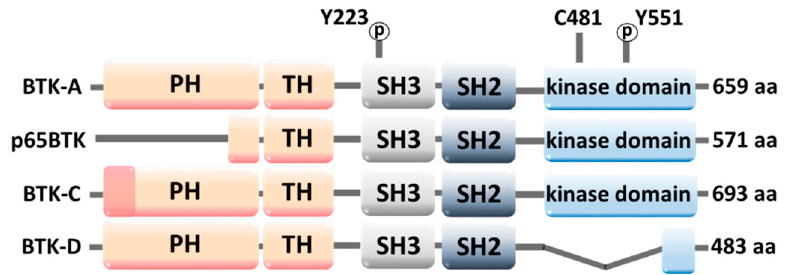
Figure 2. Structures of BTK isoforms. pY223 and pY551 are activating phosphorylation sites; C481 is a binding site for BTK inhibitors ibrutinib, spebrutinib, and acalabrutinib [10]. In this review, the term “BTK” refers to the BTK-A isoform unless it is clearly stated otherwise.